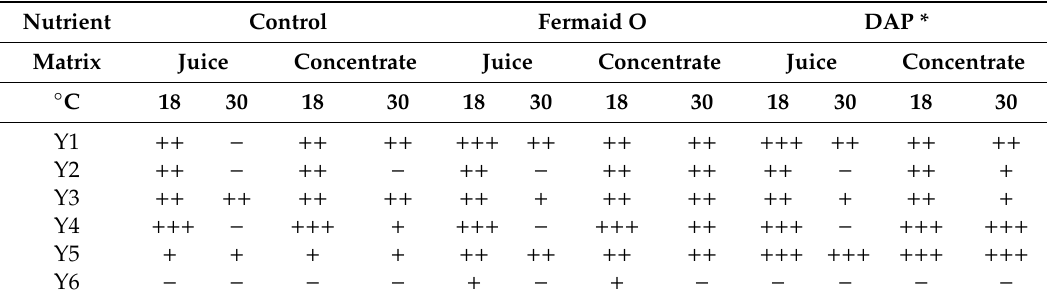
Table 2. Color reaction intensity of H 2 S (hydrogen sulfide) formation on the selective lead acetate